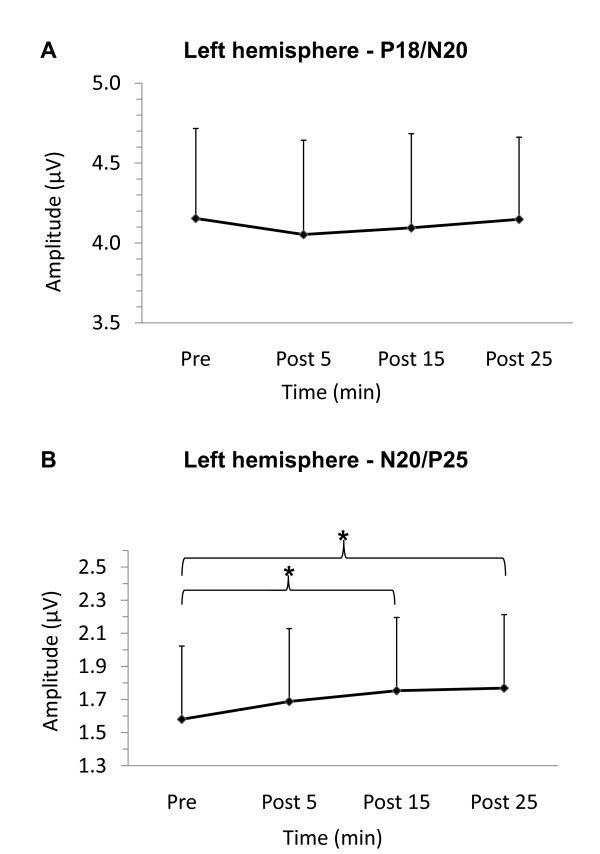
Left-hemisphere SEPs. Group averaged SEPs recorded from iTBS stimulated left-hemisphere SI. A. P18/N20 peak-to-peak group averaged data (n = 11) before (pre) and following (post) iTBS at 5 min (post 5) 15 min (post 15) and 25 minutes (post 25). B. N20/P25 peak-to-peak group averaged data pre and post-iTBS (n = 11). SEP amplitude is significantly greater at 15 and 25 min following iTBS (p < 0.05). Error bars represent standard error of the mean.